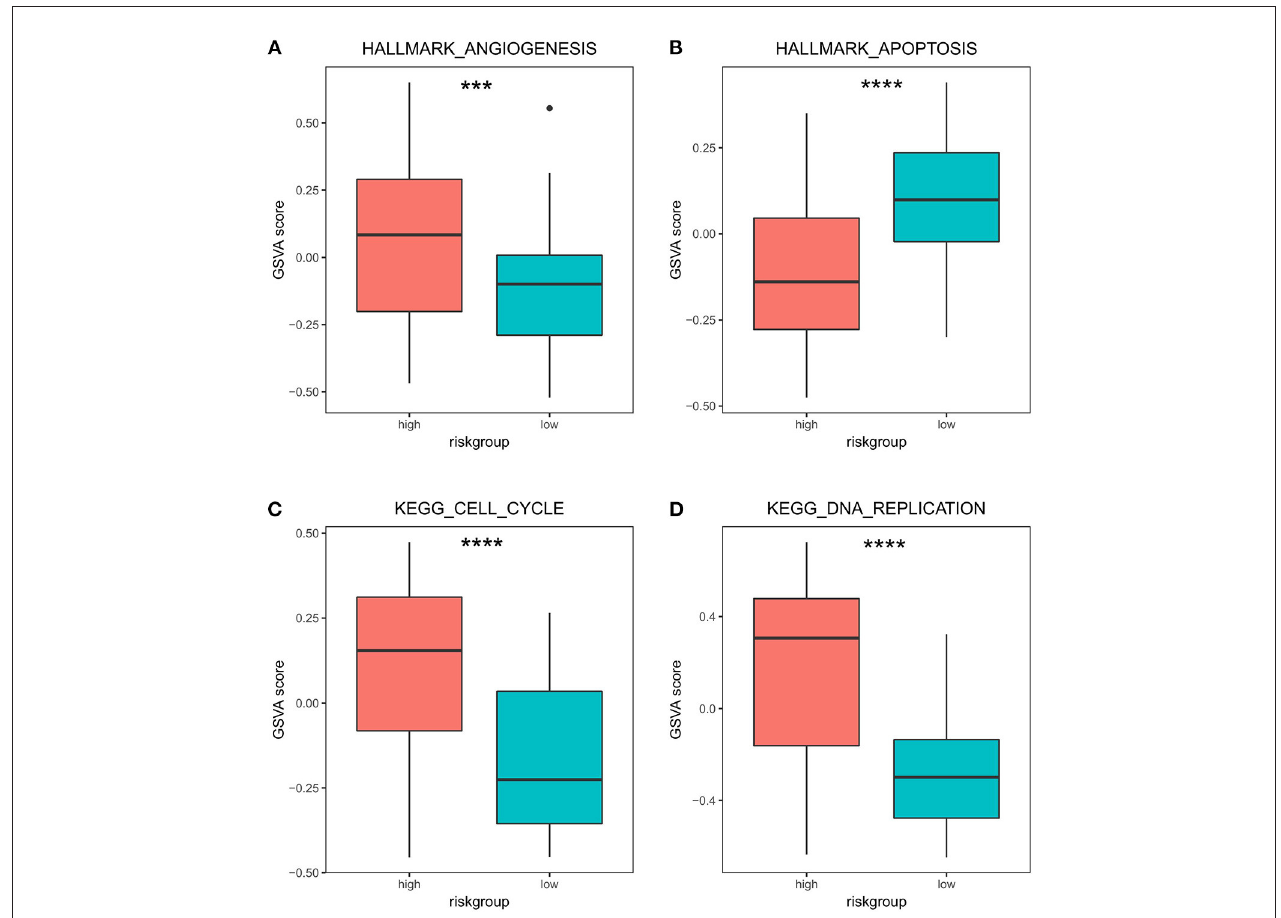
FIGURE 8 | Differences in GSVA activity scores of transfer-related pathways in high- and low-risk groups. Differences in GSVA activity scores of cancer hallmarks: angiogenesis (A) , apoptosis (B) , cell cycle (C) , and DNA replication (D) in the high- and low-risk groups. *** p < 0.001; **** p <